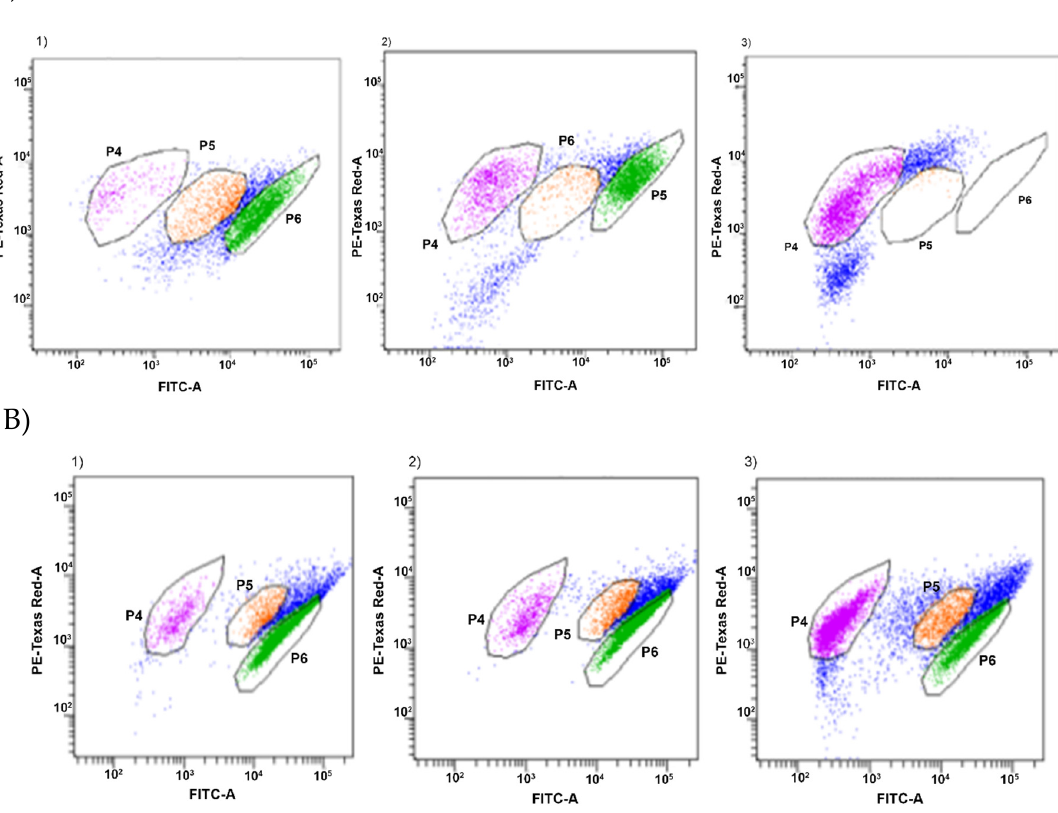
Figure 2. Two-dimensional graph of a distribution of individual fractions in cytometric analyses in case of oils extracted in our laboratory ( A ) and commercial ones ( B ) (1—CP; 2—BP oil; 3—LG oil). Analyses were carried out with P. orientalis P49 strain.